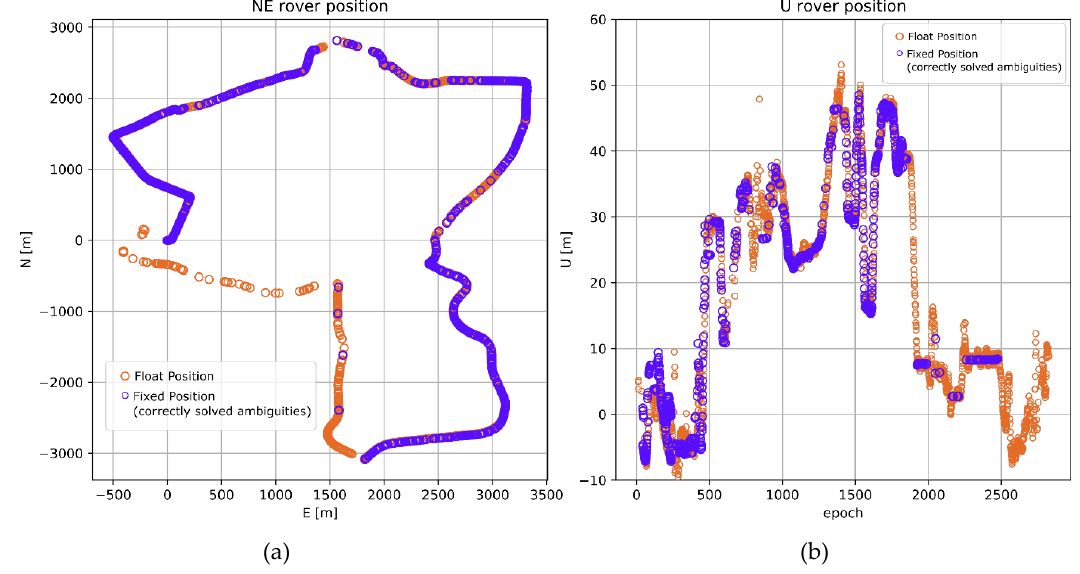
Figure 6. Rover trajectory from processing 82 km baseline (BROD), with Centre National d'Études Spatiales (CNES) real-time (RT) ionospheric corrections. ( a ) Horizontal components; ( b ) Vertical components.